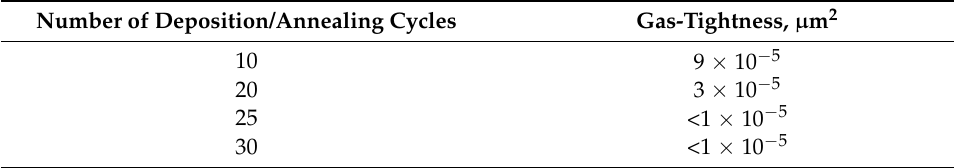
Table 2. Gas-tightness of SZY